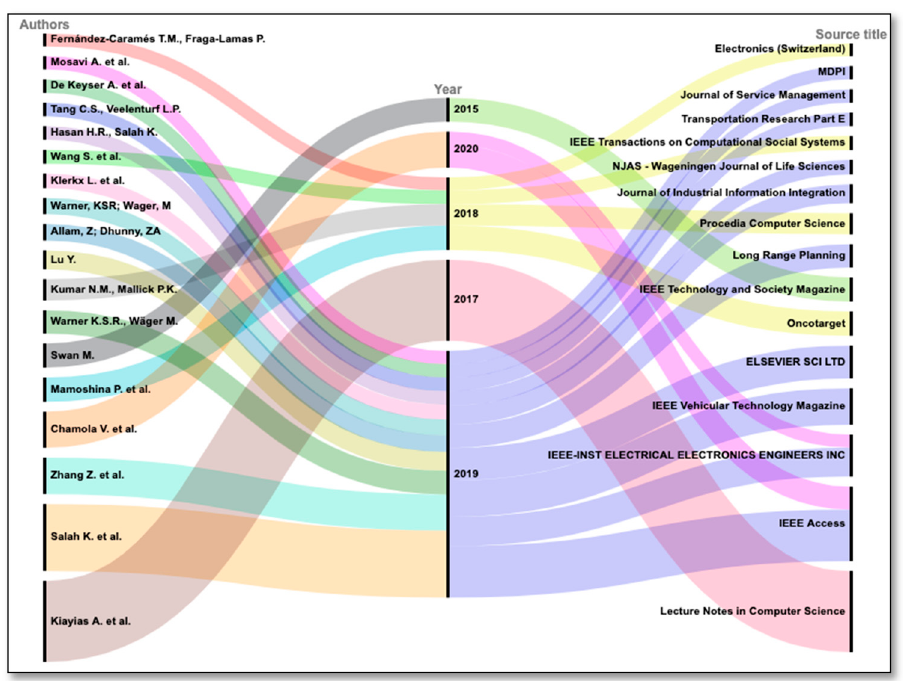
Figure 5. Alluvial diagram showing correlation between authors, years, and source tittles of top 20 highly citated documents.